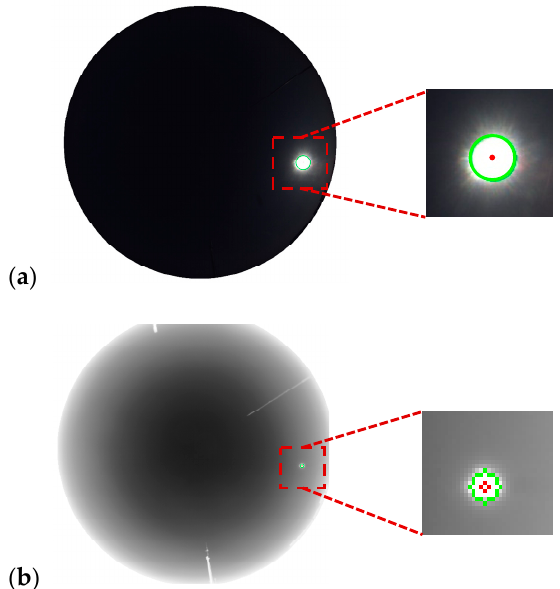
Figure 2. Center detection results of the sun area by using Hough circle transformation for ( a ) visi- ble all-sky image captured with lowest exposure time and ( b ) infrared all-sky images. The parts of the sun area are magnified in the green boxes.